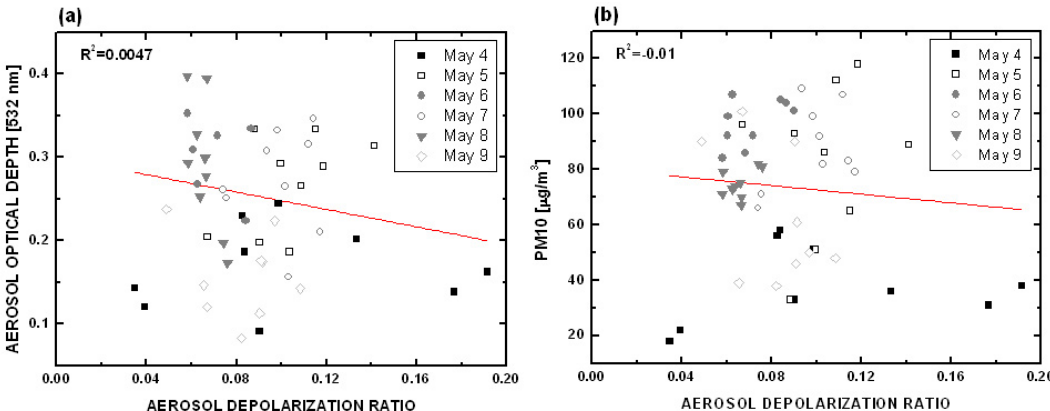
Fig. 5. Correlation between (a) the pollen depolarization ratio and aerosol optical depth and (b) between linear aerosol depolarization ratio and PM 10